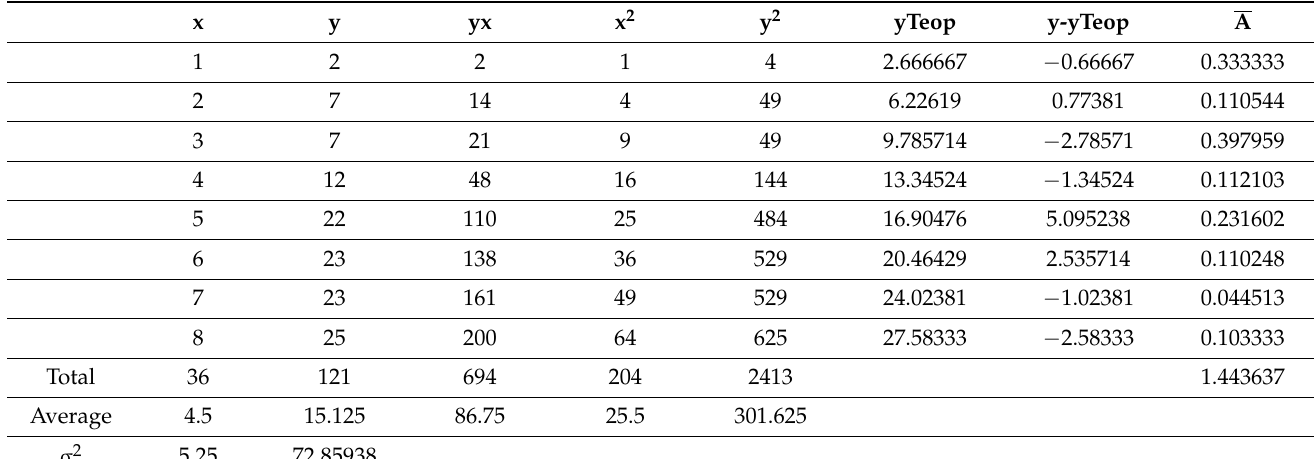
Table A3. Source statistical